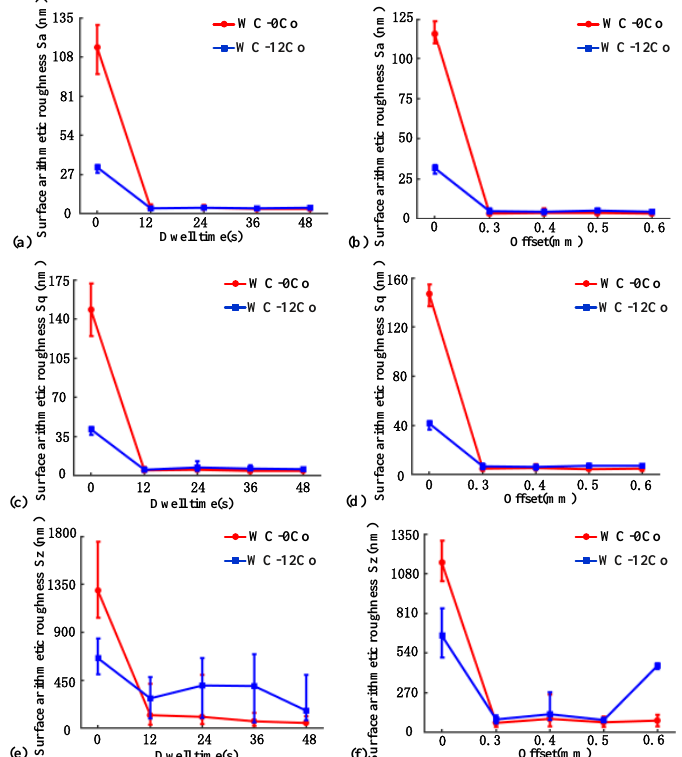
Figure 3. Surface roughness in Sa of the polishing spot on different materials under ( a ) different dwell times and ( b ) different offsets. Surface roughness in Sq of the polishing spot on different materials under ( c ) different dwell times and ( d ) different offsets. Surface roughness in Sz of the polishing spot on different materials under ( e ) different dwell times and ( f ) different offsets.